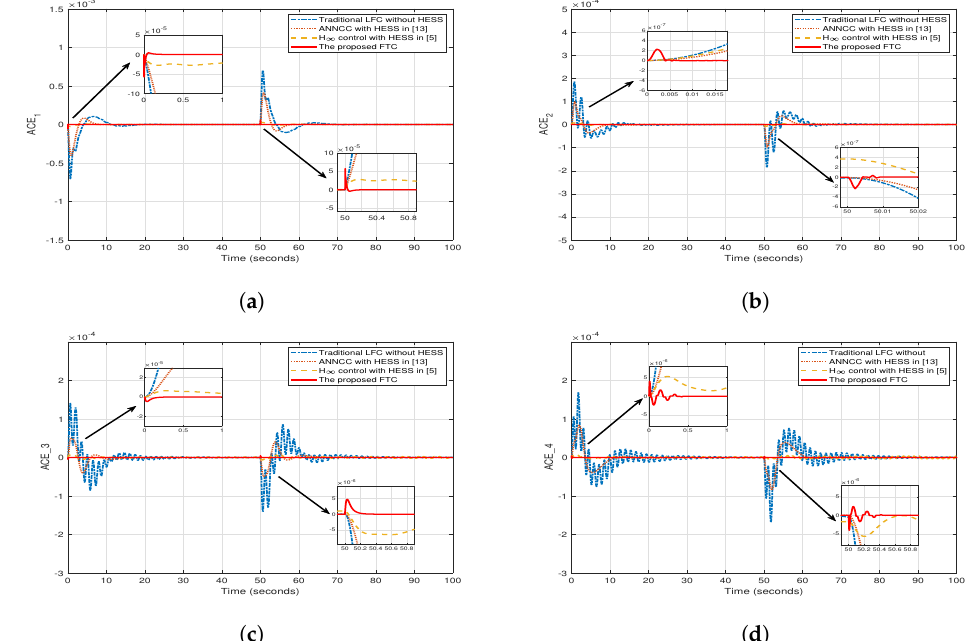
Figure 7. The ACE i ( i = 1,2,3,4) of each area subjected to a lumped disturbance of 0.02 p.u and another 0.015 p.u at time 50 s, followed by comparison with the methods reported in [5,13]: ( a ) ACE 1 ; ( b ) ACE 2 ; ( c ) ACE 3 ; ( d ) ACE 4 . ANNCC—adaptive neural network constrained control